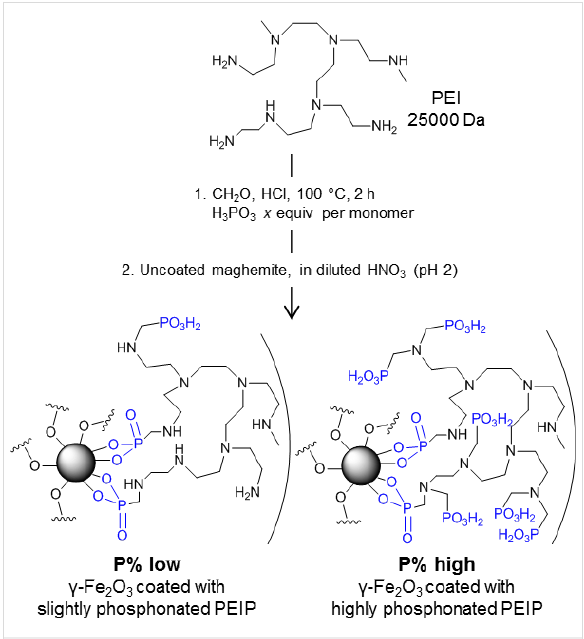
Figure 1: Synthesis of NP-PEIP. The number of phosphonates depends on the number of equivalents of phosphorous acid